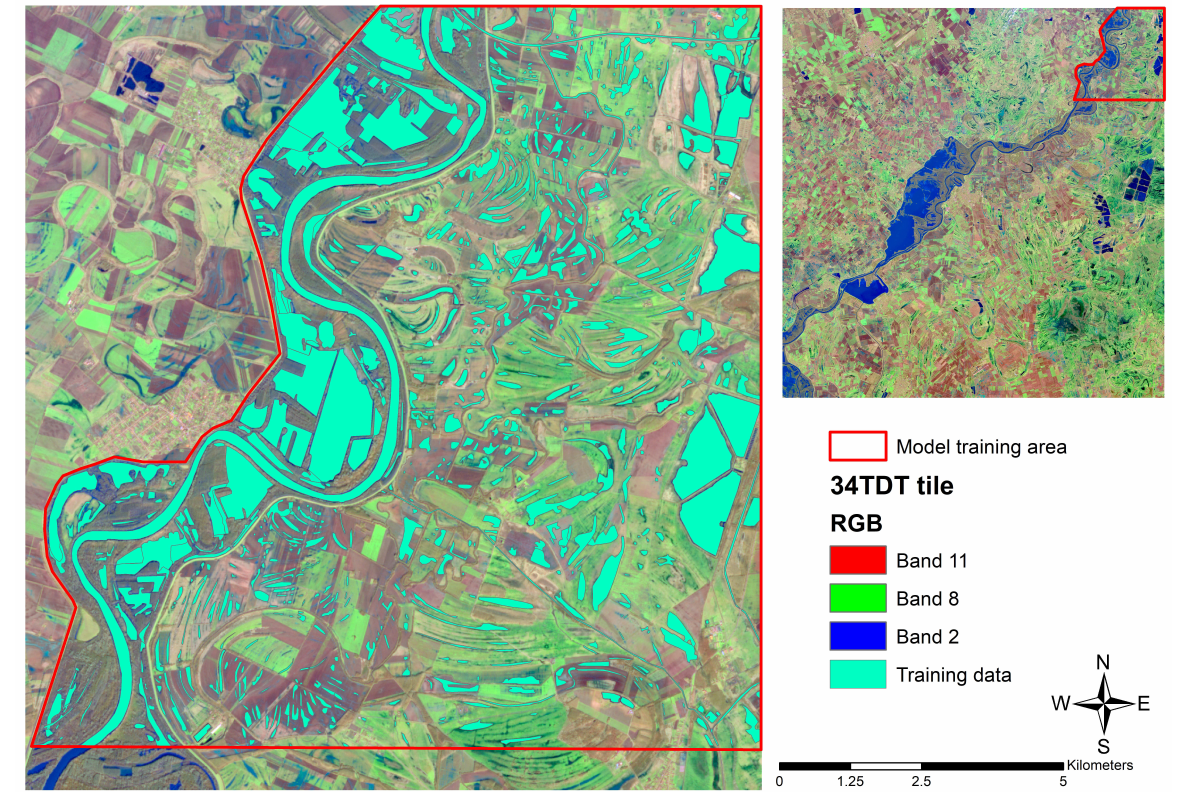
Figure 4. CNN Model training data with the original Sentinel-2 color composite ( upper right ) and the digitized permanent water polygons ( left ).